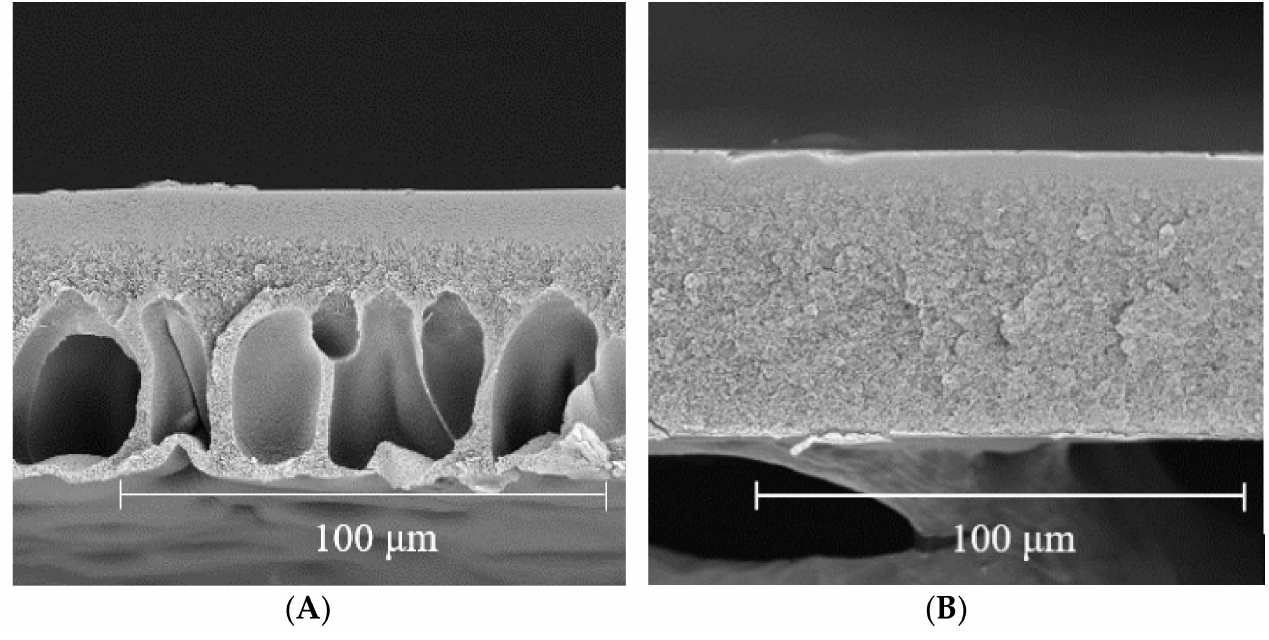
Figure 2. SEM micrographs of the cleavage of flat membranes obtained from a solution of PAN in DMSO: ( A ) 13 wt.%, ( B ) 15 wt.%